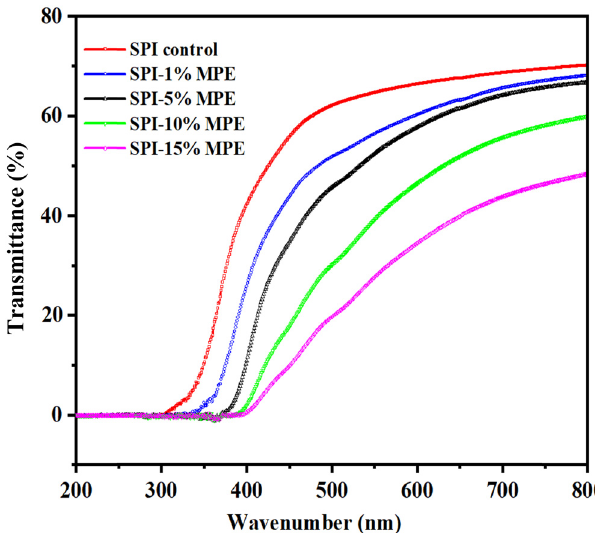
Figure 5: UV - Vis spectra of SPI fi lms with and without